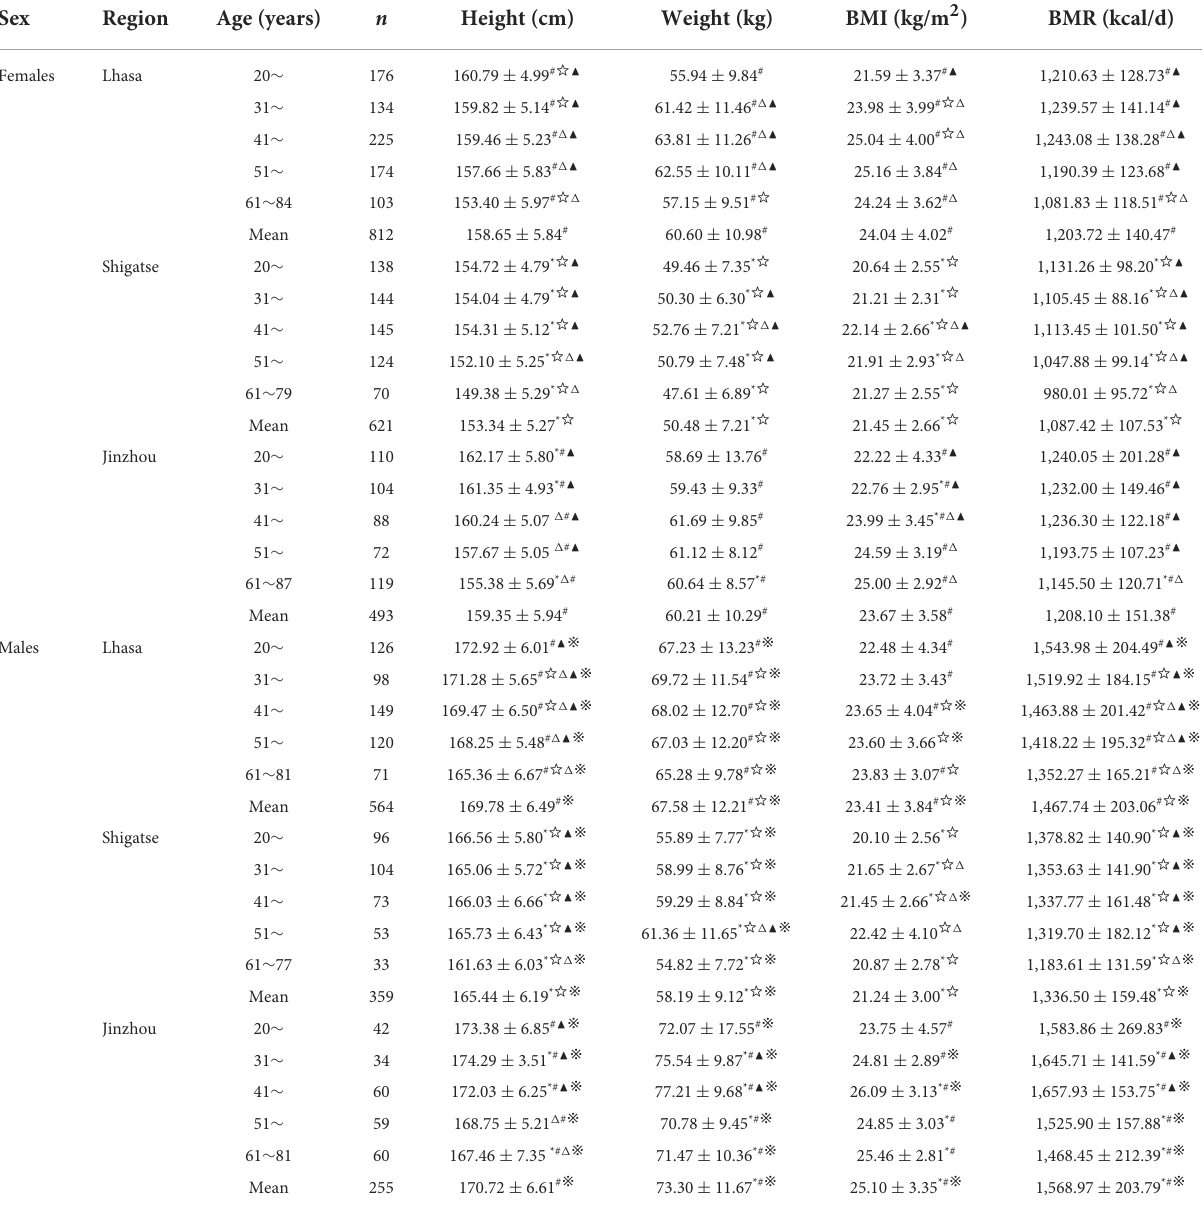
TABLE 1 Sex-specific whole-body composition measurements stratified by age and altitude. Sex Region Females